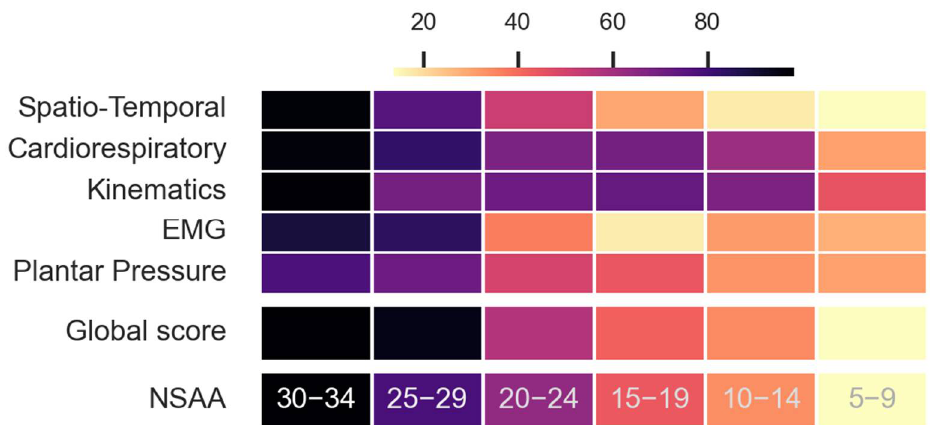
Figure 6. Progression of the multicategory score and global score for different NSAA severities. The color bar represents the normalized averaged scores for each one of the NSAA ranges, as well as for the normalized NSAA. For high NSAA values (30–34), scores are the highest and progressively de- crease until lower NSAA values (5–9). All of these decreases are not linear, indicating that each category is impacted at a distinct stage of the disease’s development.